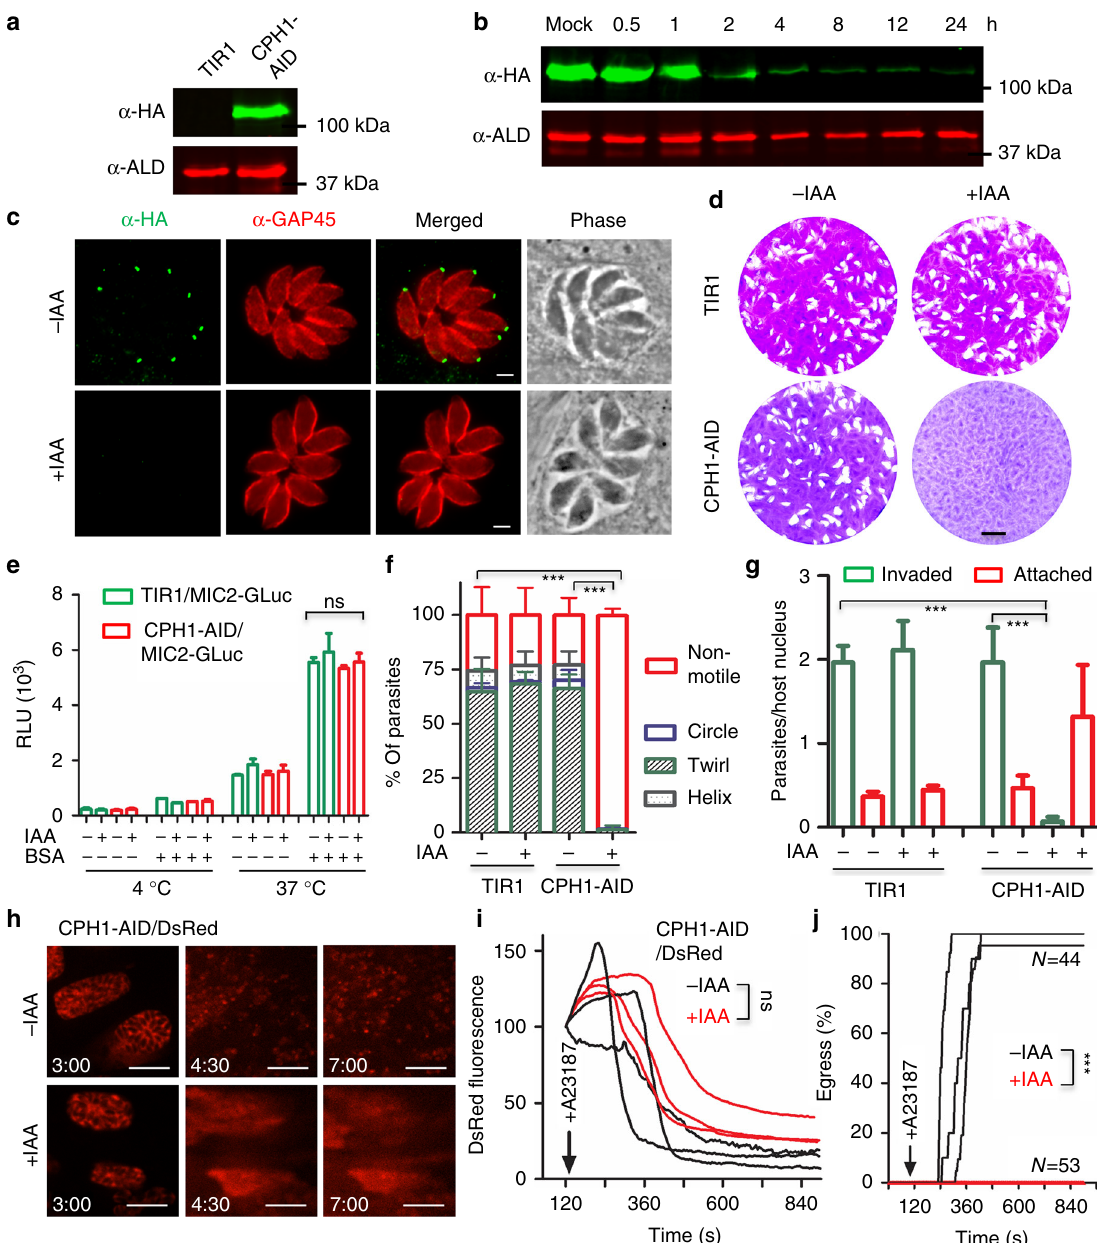
Fig. 2 CPH1 is essential for parasite motility, invasion, and egress but not for microneme secretion. a Western blot analysis of CPH1 endogenously tagged with AID-3HA ( α -HA) in the parental TIR1 line (shown for comparison). Aldolase ( α -ALD) loading control. b Degradation of CPH1-AID triggered by addition of 500 µ M auxin (+IAA) for different times (h), vs. mock, 0.1% ethanol ( − IAA). Western blot performed as in a (Supplementary Fig. 3A). c Immuno fl uorescence microscopy of CPH1-AID parasites grown ± IAA for 24 h stained using mouse anti-HA (green) and rabbit anti-GAP45 (red). Scale bar = 2 µ m. d Plaque formation with TIR1 and CPH1-AID lines grown ± IAA for 7 days. Scale bar = 0.5 cm. a – d Representative of three or more experiments with similar outcomes. e Microneme secretion following stimulation with bovine serum albumin (BSA) plus 1% ethanol for 10 min. f Parasite motility was recorded by video microscopy, manually scored, and plotted as percentage of total. *** P < 0.0001. g Parasite invasion into HFF cells was examined after 20 min challenge. *** P < 0.0001. e – g Parasite lines were grown in ± IAA for 40 – 44 h and extracellular parasites were collected and immediately used for assays. Mean ± SEM ( n = 3 experiments, each with 3 technical replicates, n = 9). One-way ANOVA with Kruskal – Wallis test ( e ) or with Tukey ’ s multiple comparison ( g ) or two-way ANOVA ( f ) with Tukey ’ s multiple comparison. h – j Parasite lines were grown in ± IAA for 36 h and video microscopy was performed after addition of 2 μ m A23187. h Representative example of images from three independent experiments showing time lapse recordings of DsRED diffusion (time stamp min:s). Scale bar = 20 µ m. i Mean of replicates ( n = 8 vacuoles) from each experiment plotted as separate lines ( n = 3 experiments). j Mean of replicates ( n = 44 − IAA, 53 +IAA in total) from each experiment plotted as separate lines ( n = 3 experiments). *** P < 0.0001. Two-way ANOVA with Tukey ’ s multiple comparison. RLU relative luminescence units, ns not signi fi